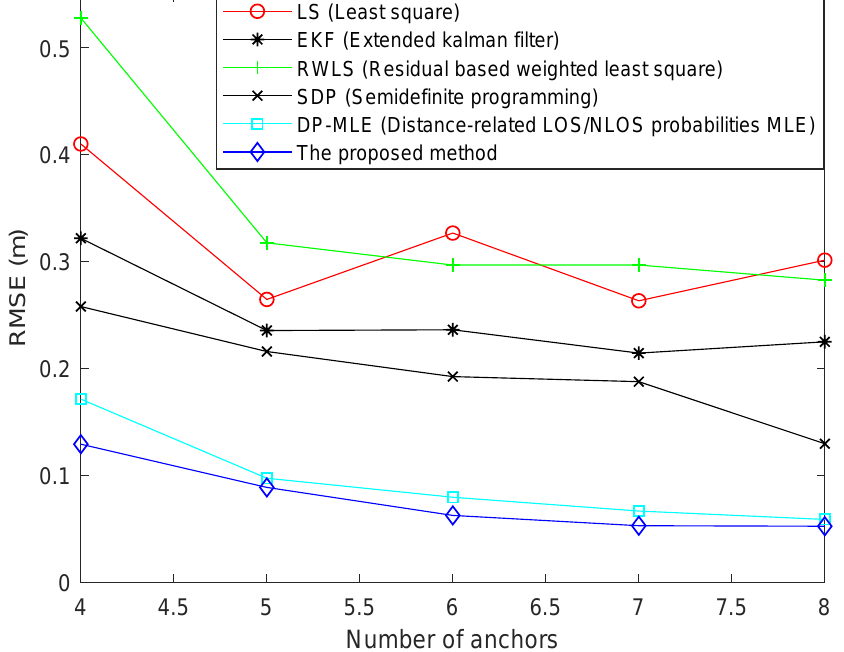
Figure 4. Root mean square error (RMSE) of different algorithms using different numbers of